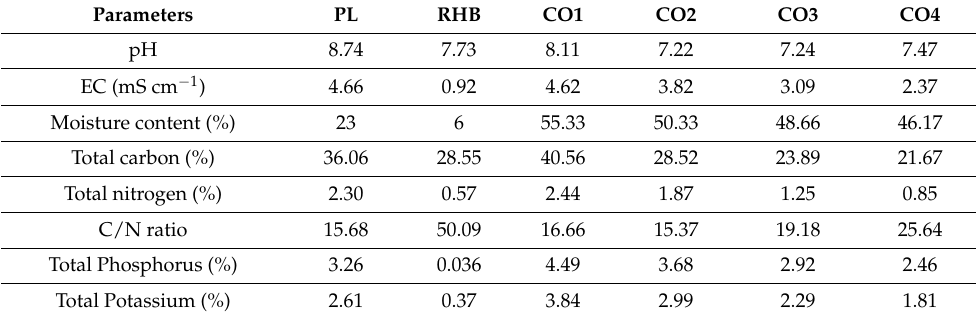
Table 3. Physicochemical characteristics of organic amendments used in